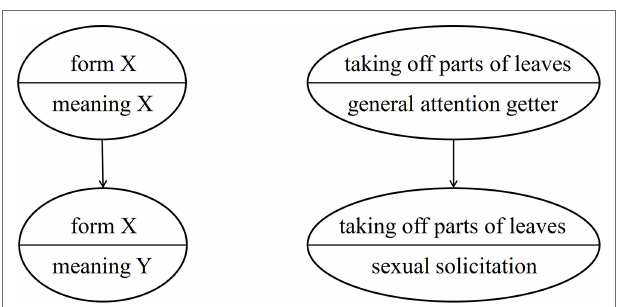
FIGURE 2 | Group-specific semantic